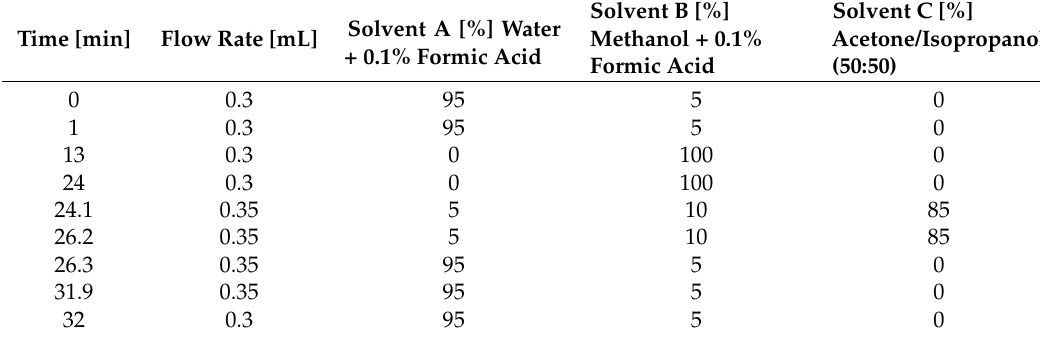
Table A2. Solvent gradient for liquid